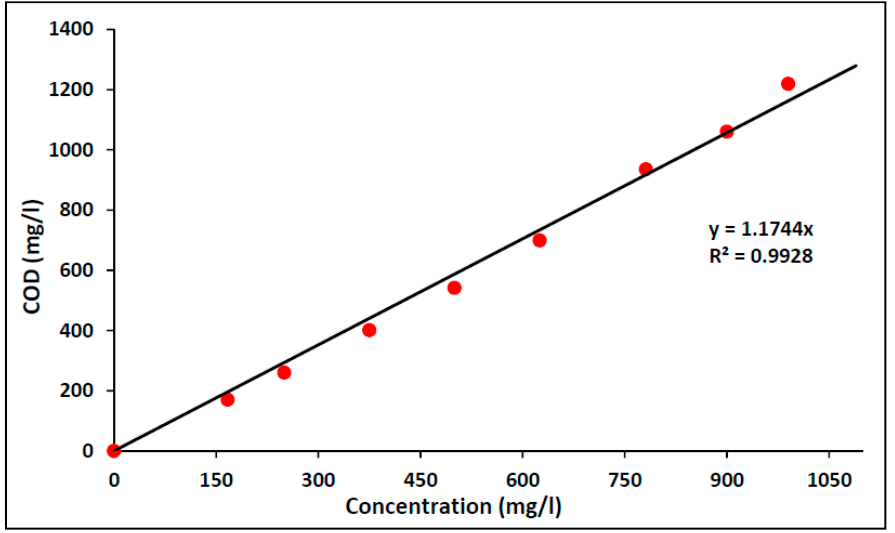
Figure 7. Chemical oxygen demand (COD)–saccharose relationship.